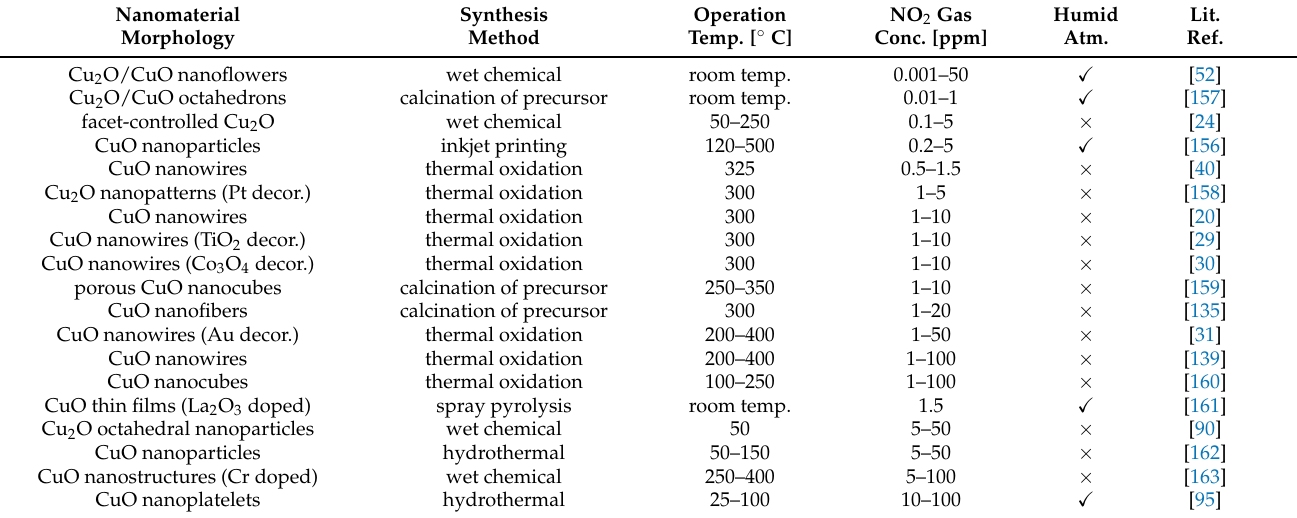
Table 5. A summary of sensing nitrogen dioxide (NO 2 ) with copper oxide-based devices.